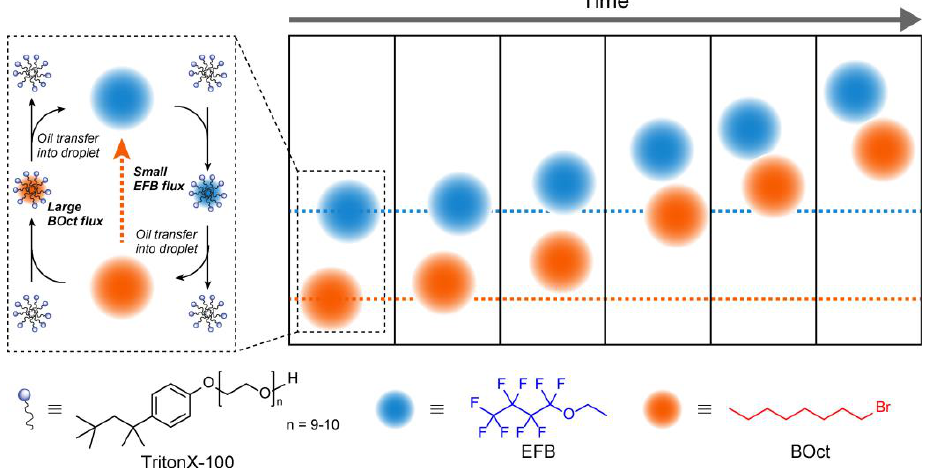
Figure 7. Schematic illustration of a self-propelled oil droplet, 1-bromooctane, chasing a different self-propelled oil droplet, ethoxynonafluorobutane, in a Triton X-100 aqueous solution. self-propelled oil droplet, ethoxynonafluorobutane, in a Triton X-100 aqueous